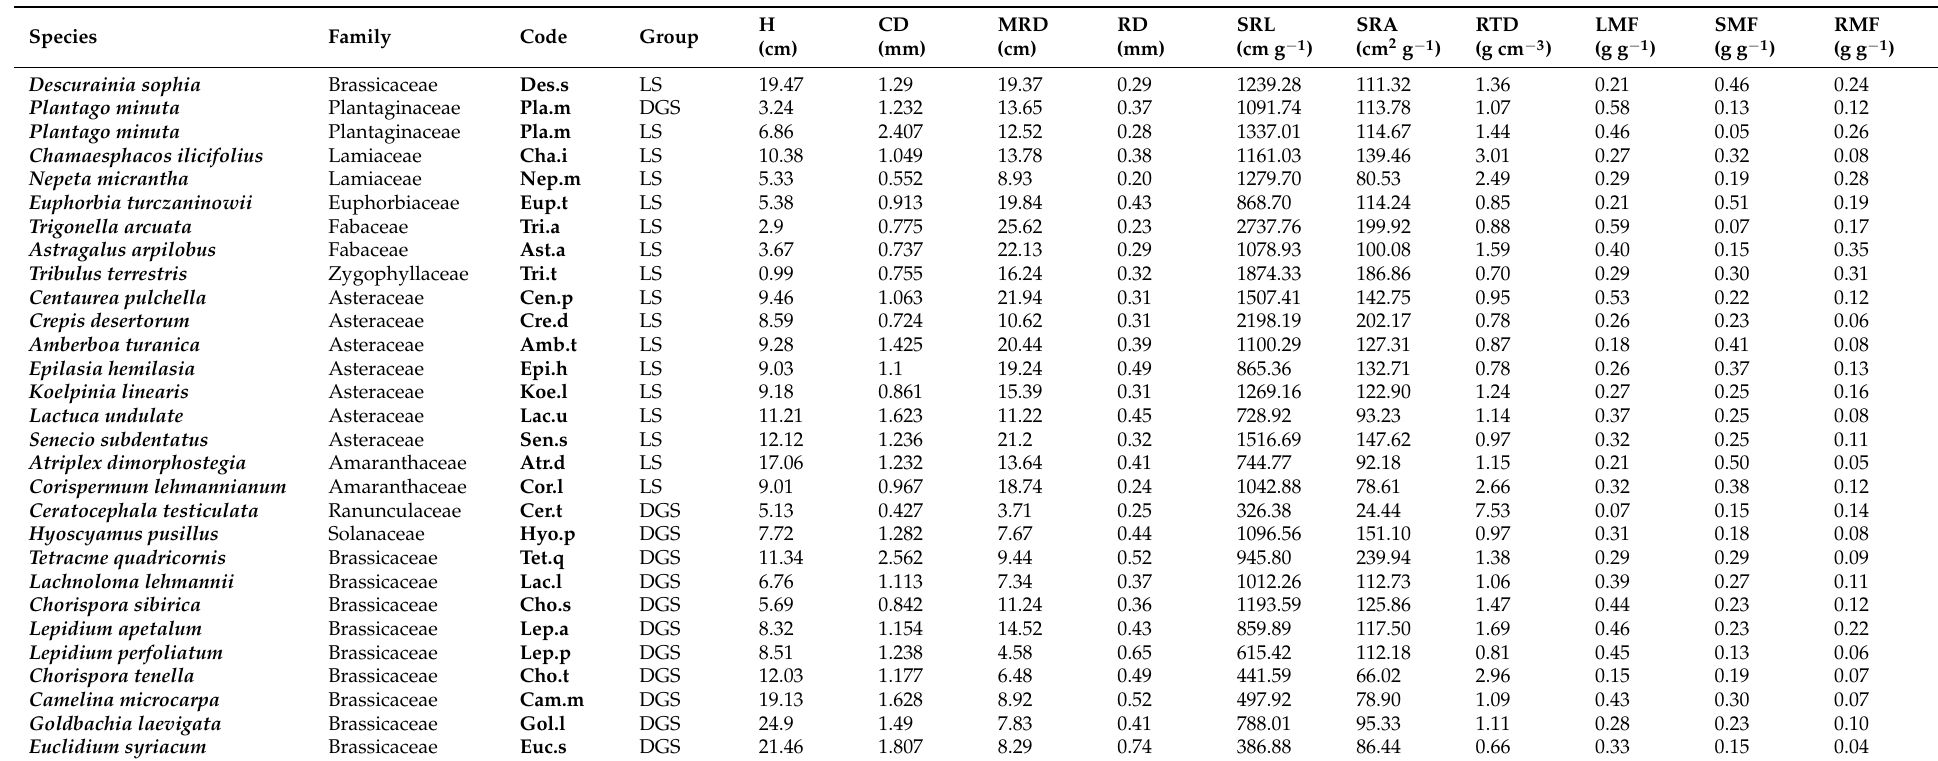
Table 2. List of 50 annual ephemeral species in the cold desert of the Chinese Junggar Basin in 2022. LS represents the species rooting in loose sand, and DGS represents the species rooting in dense or gravelly sand. For each species, we calculate the average value of each trait. The meanings of H, CD, MRD, RD, SRL, SRA, RTD, LMF, SMF, RMF are plant height, root collar diameter, maximum root depth, root diameter, specific root length, specific root area, root tissue density, leaf masss fraction, stem mass fraction, and root mass fraction,